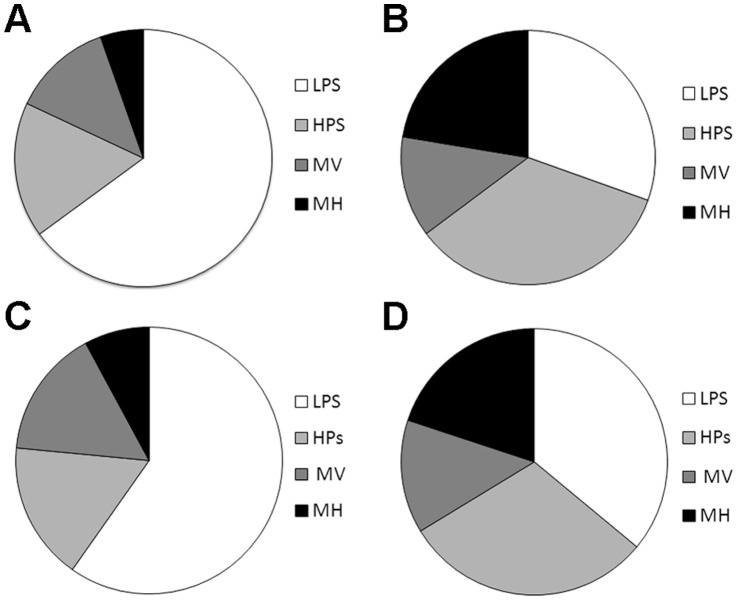
The relative proportions of lamp classes associated with different land-uses.(A) Roads/pavements and (B) other built surface OSMM land-use parcels, located within (C) housing and (D) manufacturing NLUD zones.